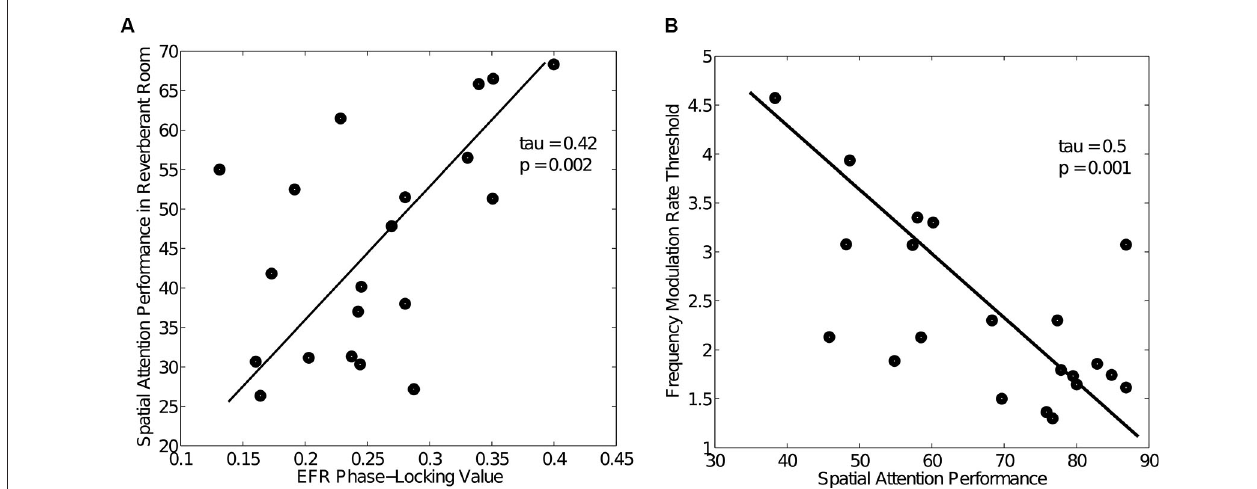
Listeners with good temporal coding of envelopes as measured by the EFR PLV were able to spatially segregate the competing speech streams and performed well. (B) Relationship between spatial attention task performance and frequency modulation (FM) detection thresholds (data from Ruggles et al., 2011), a task known to rely on robust encoding of